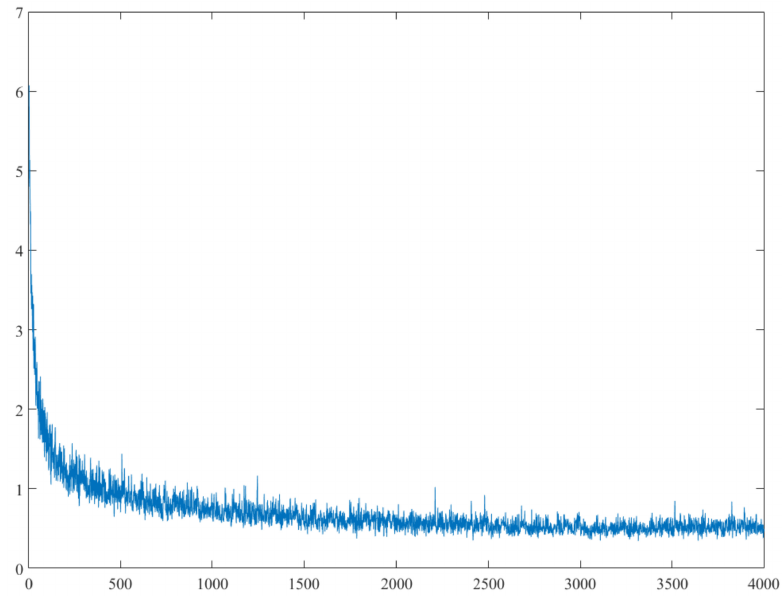
Figure 5. The abscissa represents the training times and the ordinate represents the total loss of the network, and the loss no longer shows a decreasing trend after training of 3000